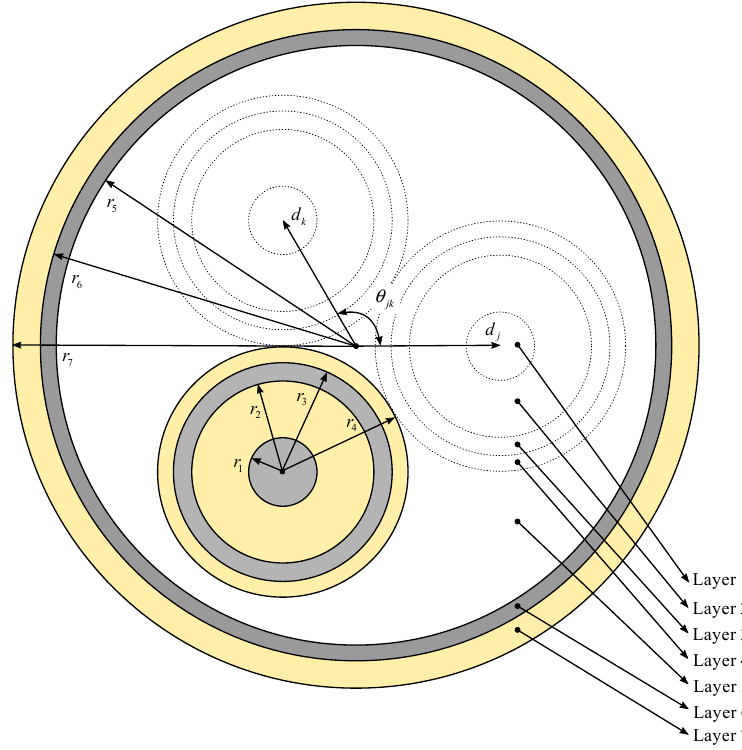
Figure 2. Simplified cross-section of a three-core submarine cable. Table 1. Simplified layers of a three-core submarine